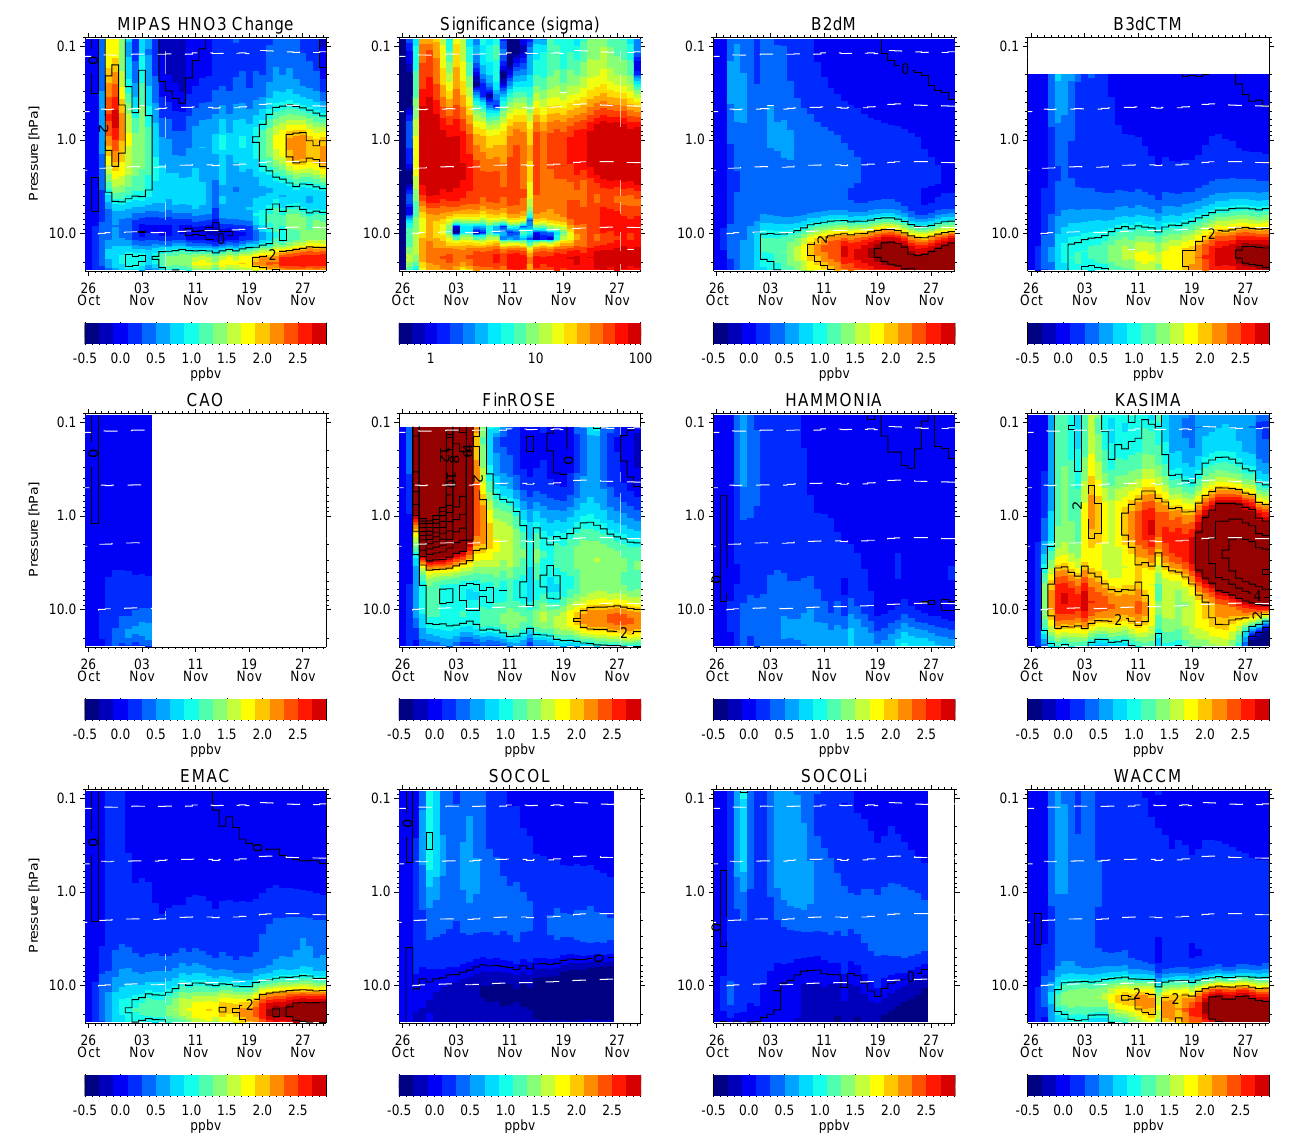
Fig. 22. Temporal evolution of area-weighted averages of HNO 3 changes with respect to 26 October 2003 in MIPAS observations and model simulations at 70–90 ◦ N. Solid contour lines reflect 1ppbv steps. The significance of observed HNO 3 changes (in units of σ ) is shown in the upper second panel (from the left).